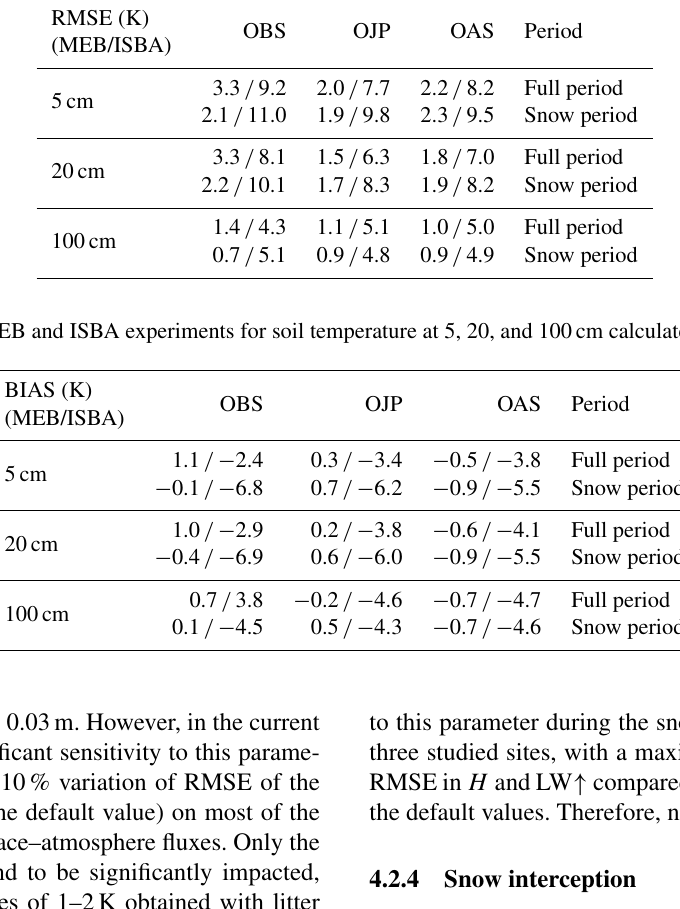
Table 6. RMSE for the ISBA-MEB and ISBA experiments for soil temperature at 5, 20, and 100cm calculated over half-hourly data.